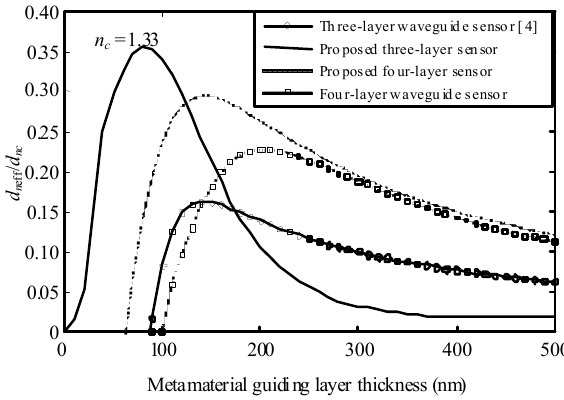
Fig. 3 Plot of cover layer sensitivity variation versus film thickness for the proposed three-layer and four-layer sensors, three-layer waveguide sensor proposed in [4], and four-layer waveguide sensor (dielectric guiding layer). The refractive indices used in the simulation are: n s = 1.471, n a = 1.45, and n c = 1.33.